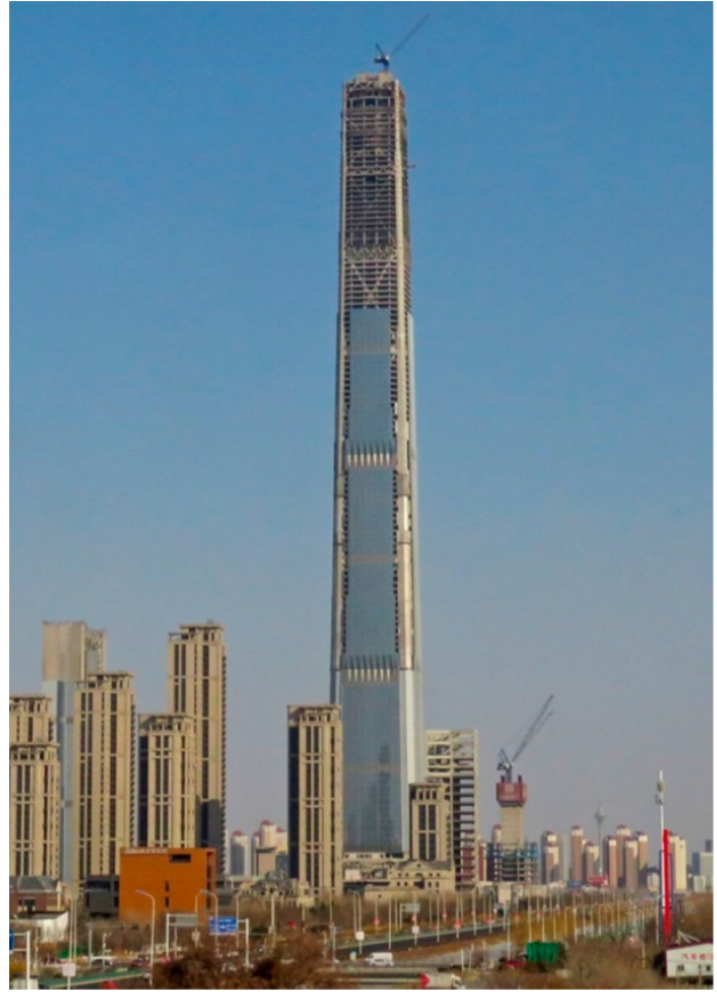
Figure 17. Goldin Finance 117 (unfinished) in Tianjin, China. (Source: Wikipedia).